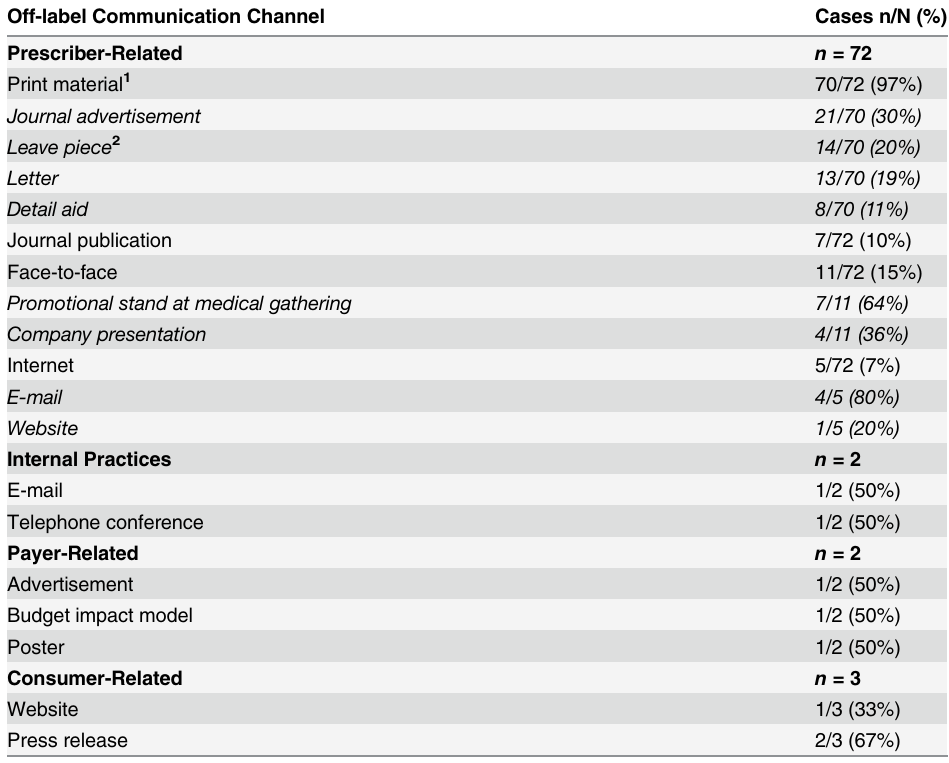
Table 1). Off-label use was also sometimes encouraged by disseminating journal publications covering the unapproved use (7/72, 10%). For example, marketers disseminated a review article from a stand at a conference that discussed ongoing or planned clinical studies for their com- pany ’ s immunosuppressant drug Myfortic (mycophenolate sodium) in different patient popu- lations and treatment regimens including withdrawal or avoidance of steroids for which the drug had no license (no. 1851/6/06). Communication “ face-to-face ” was also described (11/72, 15%) as, for instance, in the Fostair ruling described in Table 1 (no. 2435/6/12). Internal, payer-related, or consumer-related practices. There were two descriptions of internal practices (2/74, 3%). In one case, an anonymous company representative had been encouraged during an internal telephone conference to promote the dermatological antibiotic Aldara (iniquimod cream) off-label to plastic surgeons to shrink lesions prior to surgery when the drug was only indicated for the topical treatment of small superficial basal cell carcinomas (no. 2102/3/08). Payer-related practices were reported in two cases (2/74, 3%). An example detailed in Table 1 pertained to promotion of the anaesthetic Versatis (lidocaine medicated plaster) in a conference poster (no. 2330/7/10). Three rulings described off-label marketing to consumers (3/74, 4%). In one case, the company had used a medical journal ad to refer health professionals, and encouraged health professionals to refer patients, to a patient group website that included a newsletter giving information about the use of the anti-Parkinson drug Requip (ropinirole) for restless leg syndrome, an unlicensed indication (no. 1801/2/06). In another